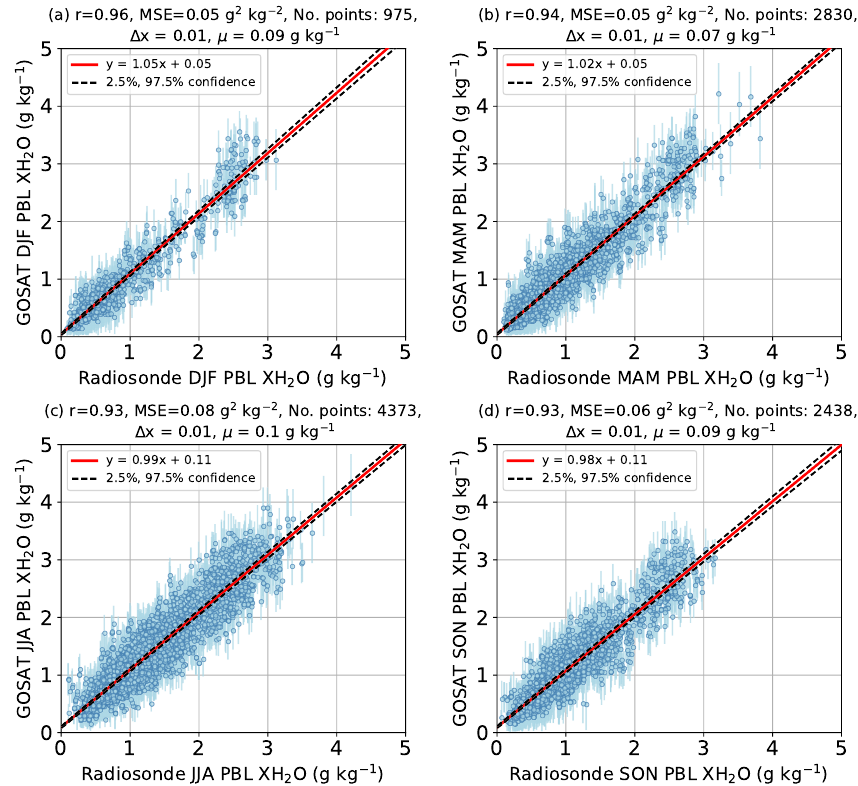
Figure 8. Seasonal comparisons of GOSAT PBL XH 2 O with ARSA radiosonde matches for northern hemisphere; ( a ) winter—December, January and February, ( b ) spring—March, April and May, ( c ) summer—June, July and August, and ( d ) autumn—September, October and November. Matches are collated between June 2009 and May 2017 from GOSAT overpasses that are within 100 km of the ARSA station and ± 30 min of launch. In addition to the linear fit (red line), the 2.5% and 97.5% confidence intervals (black dashed lines), the mean bias value ( µ ), the correlation (r), mean square error (MSE), error of the linear fit gradient ( ∆ x) and number of matches are included for each season.